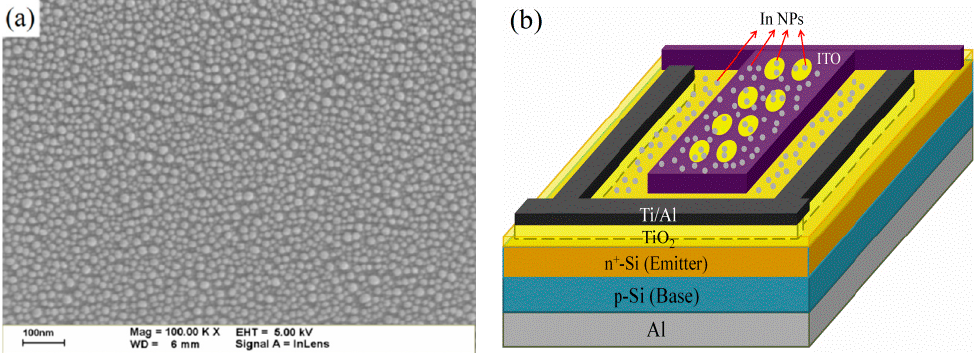
Figure 7. ( a ) SEM images showing the size and profile of In-NPs; ( b ) Schematic diagram of proposed MOS solar cell with In-NPs and perforated ITO-electrode.